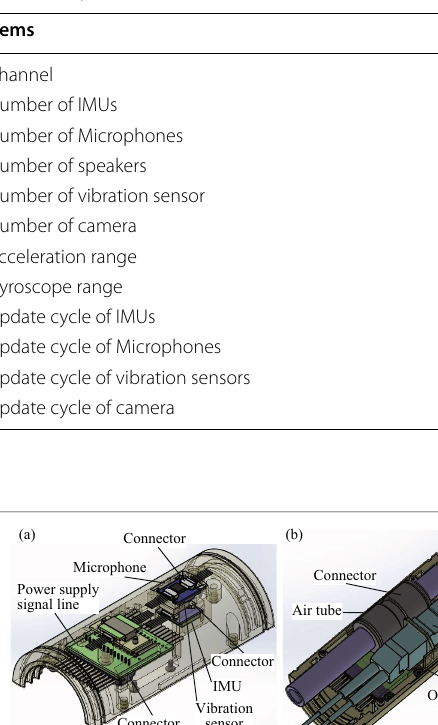
Table 2 Specifications of sensors